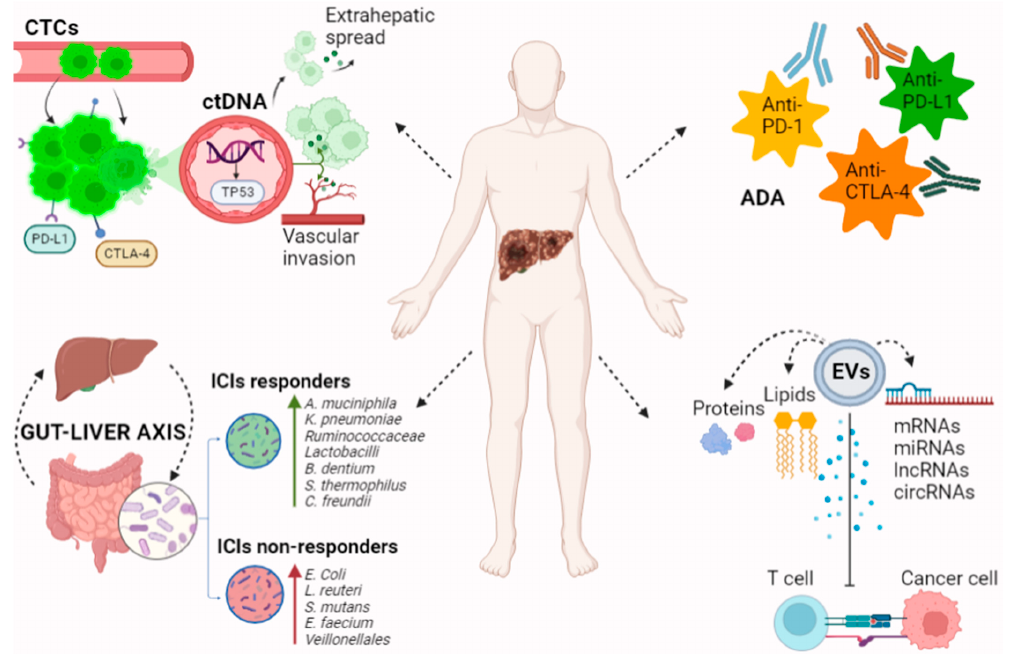
Figure 1. Novel biomarkers for immunotherapy in patients with HCC. CtDNA and CTCs reflect tumor growth and invasiveness of HCC. Genome analysis of ctDNA allows for the detection of prognostic tumor mutations. CTC levels correlate with tumor extension and may have a role in predicting tumor recurrence after immunotherapy. EVs contain proteins, lipids, DNAs, mRNAs, miRNAs, and non-coding RNAs including circRNAs and lncRNAs. These products influence ICIs’ efficacy by down- or up-regulating PD-L1 expression in the tumor microenvironment. Immune system hyperstimulation by ICIs can lead to the production of ADA. ADA directed against ICIs promote immunocomplex formation and drug clearance, potentially affecting anti-tumor efficacy. The gut microbiota’s composition and products regulate several immune and metabolic pathways in the gut–liver axis, including the response to ICIs. Gut microbiota profiles differ among ICIs